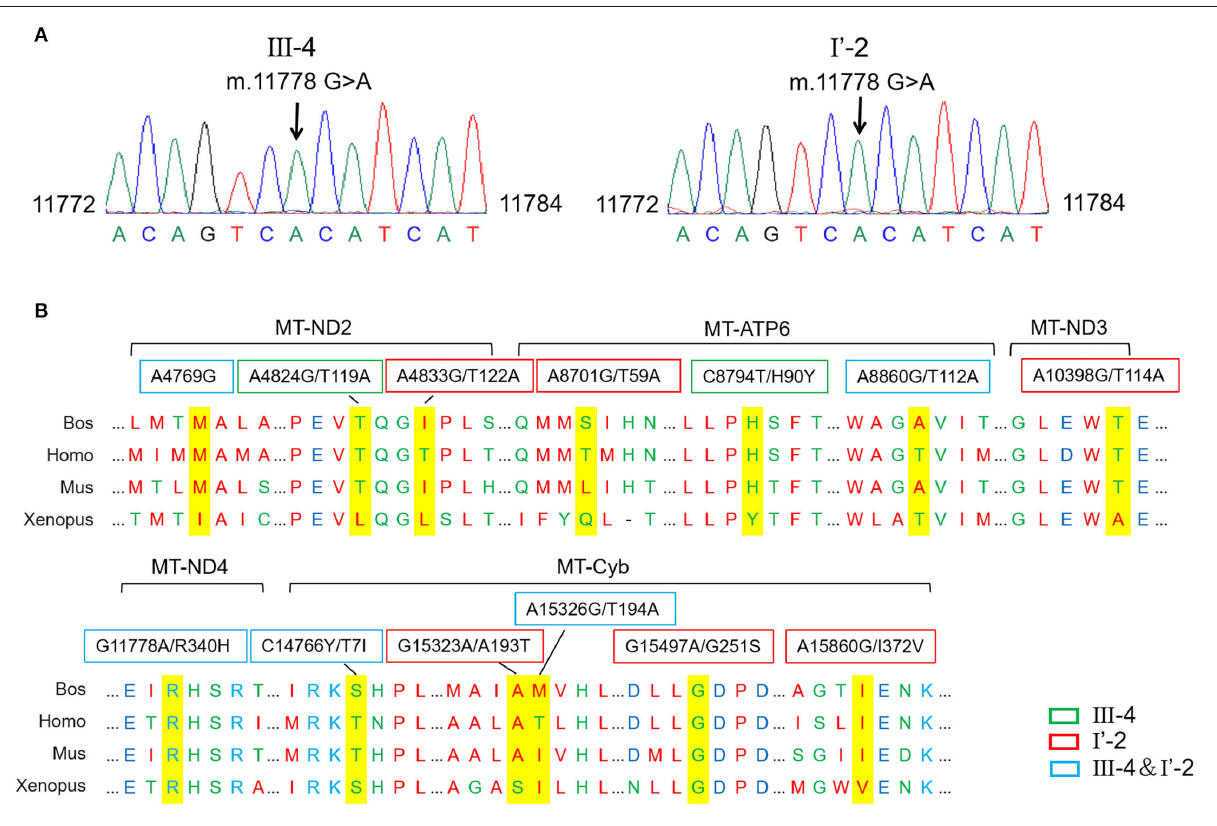
FIGURE 2 | Different mitochondrial DNA gene (mtDNA) variations of two probands. (A) The mutation m.11778G > A was confirmed in probands by the Sanger sequencing. (B) Conservative analysis of mutant amino acids in four species. Bos, Bostaurus; Homo, Homo sapiens; Mus, Musmusculus; Xenopus,